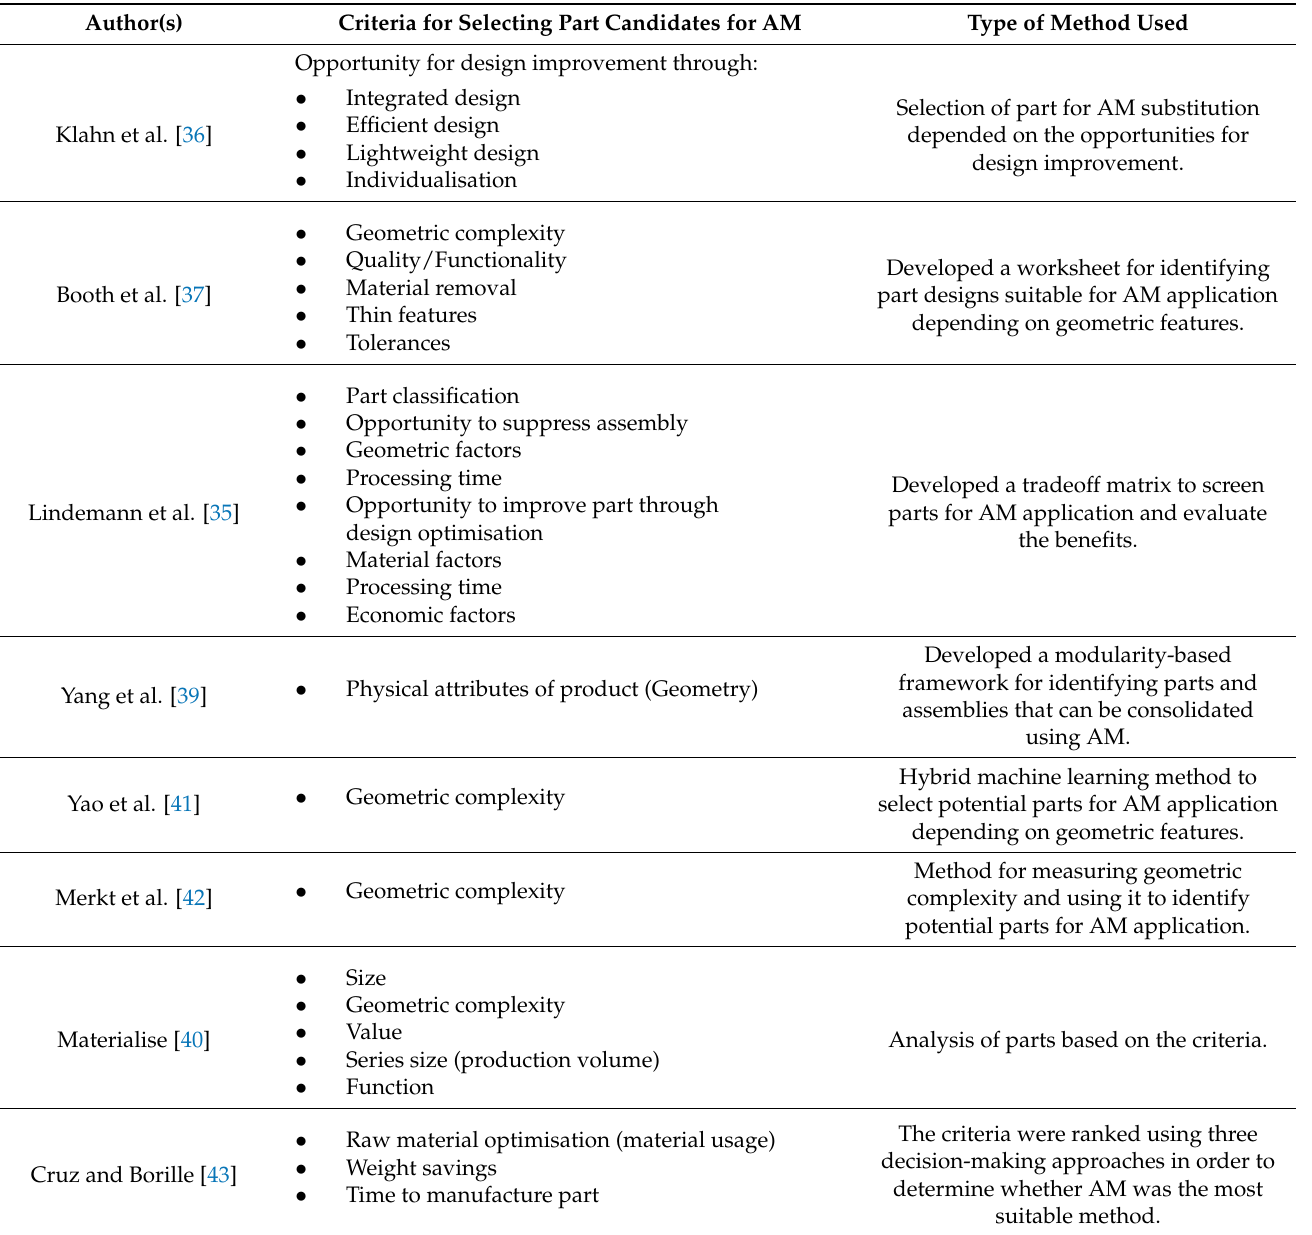
Table 1. Summary of the parameters used to select part candidates for AM